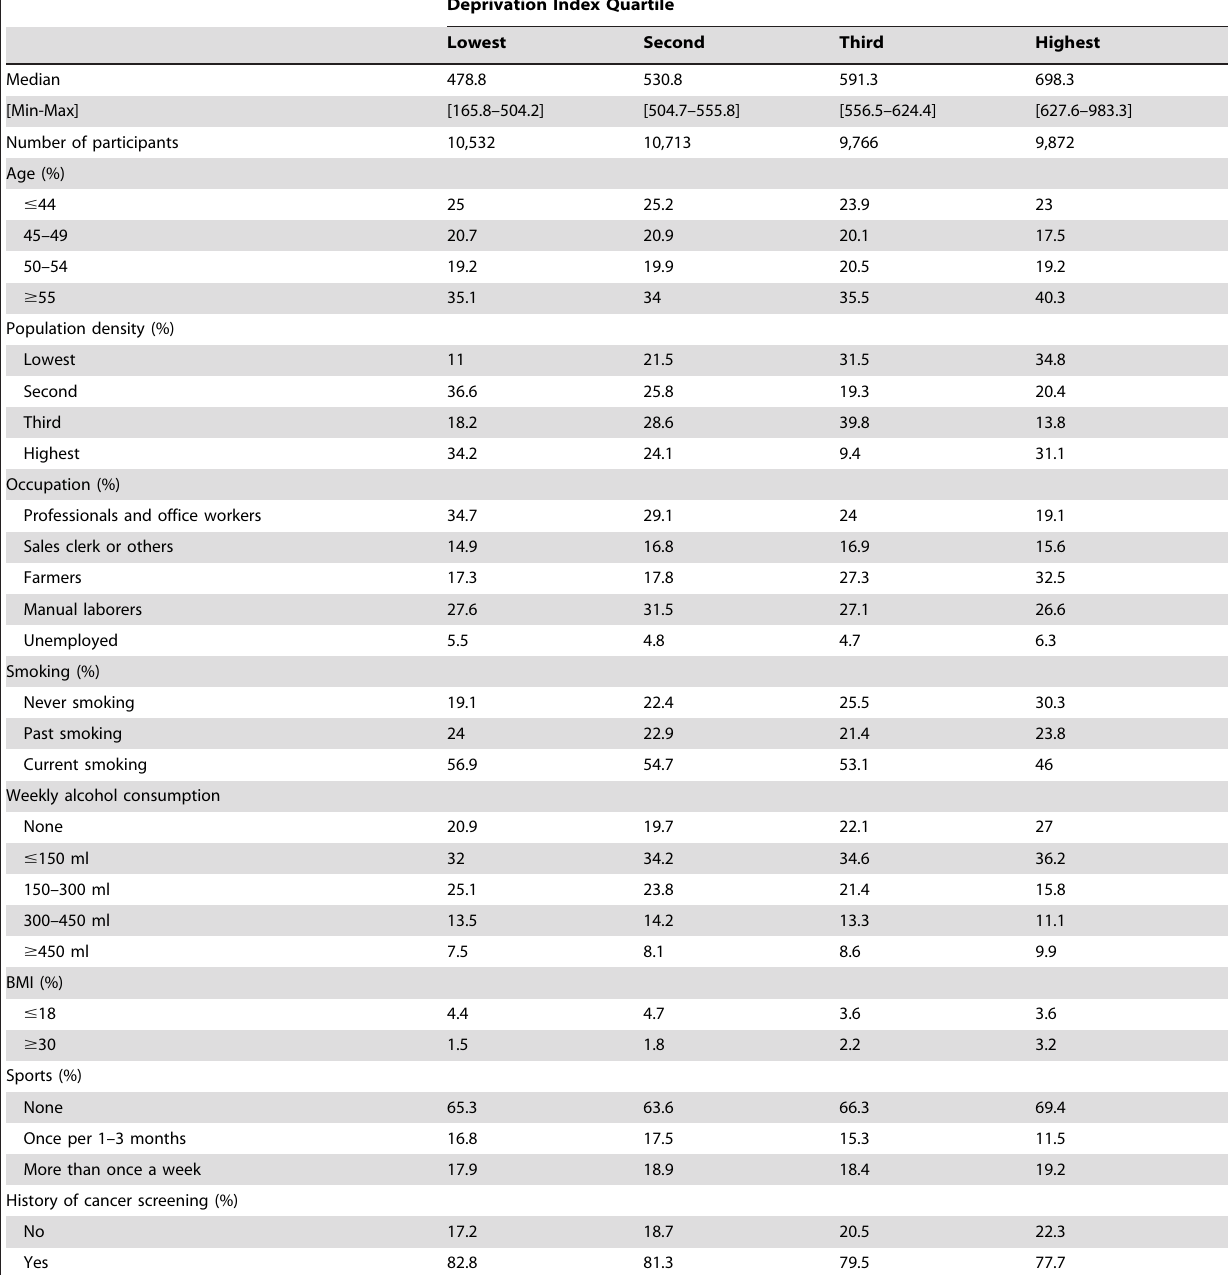
Table 1. Baseline characteristics in men